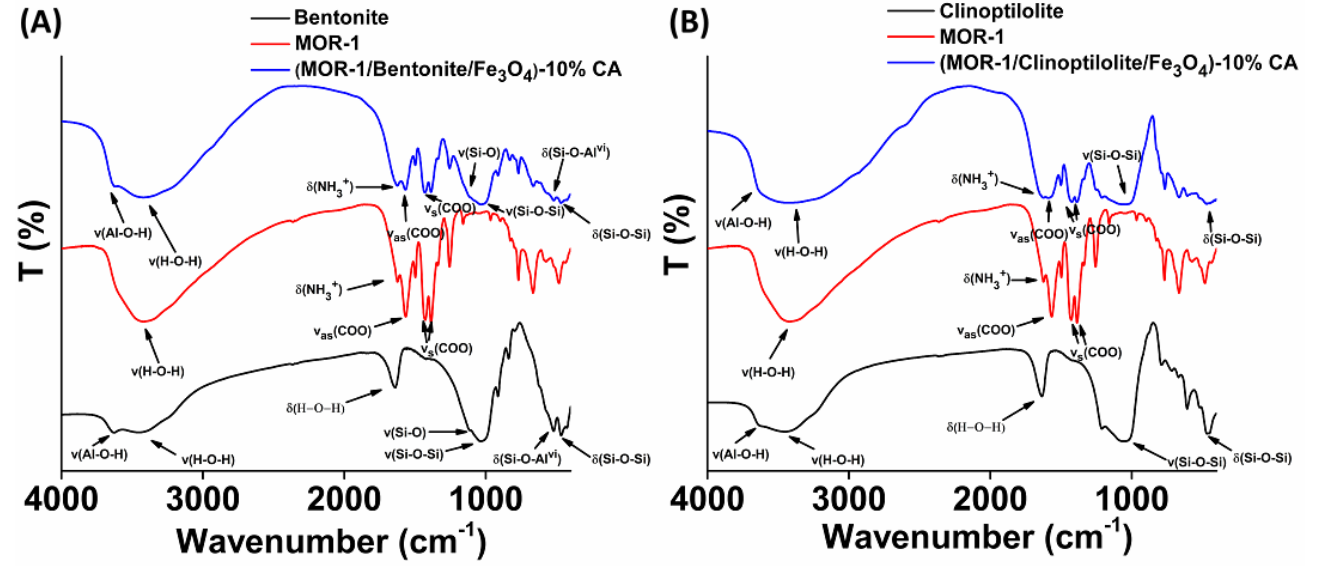
Figure 4. FT-IR spectra of ( A ) bentonite, MOR-1, and (MOR-1/Bentonite)-HA ; ( B ) clinoptilolite, MOR-1, and (MOR-1/Clinoptilolite)-HA .